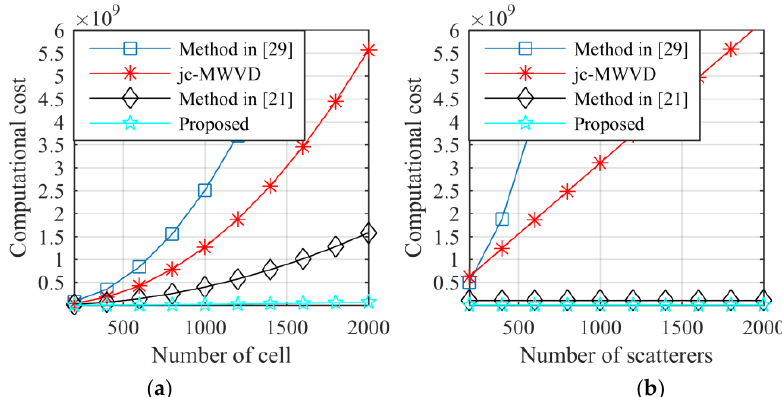
Figure 3. Computational cost comparison. ( a ) Computational cost versus resolution cell ( 𝑃 = 31 ). ( b ) Computational cost versus total scatterers ( 𝑁 = 512 ).